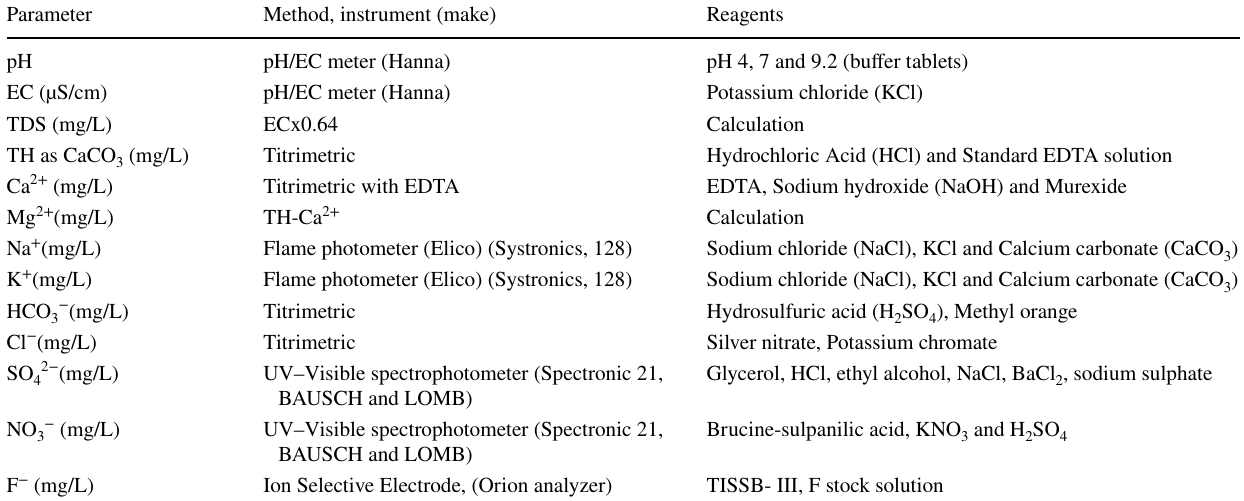
Table 2 Standard procedure of major ions of groundwater in the study area Parameter Method, instrument